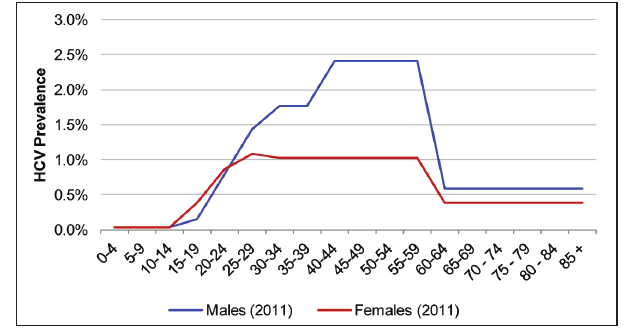
Figure 2) Age and sex distribution of anti-hepatitis C virus